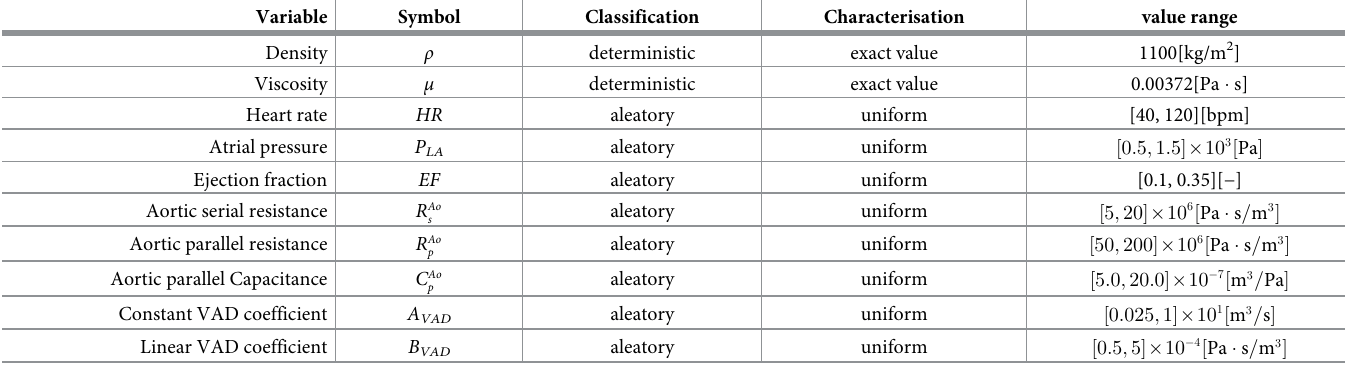
Table 4. Table of model inputs and their uncertainty